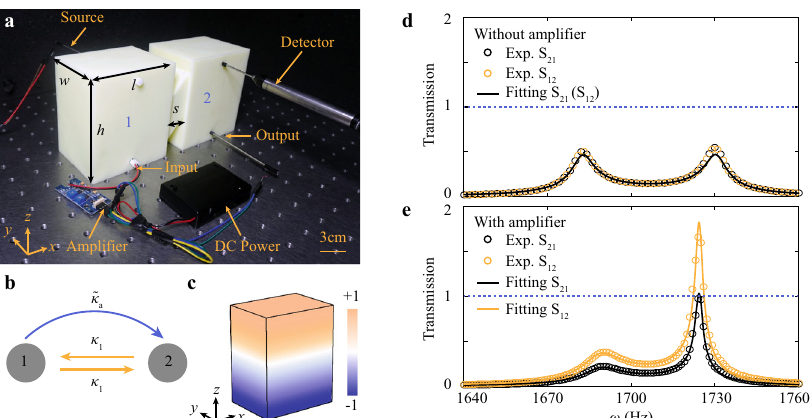
Fig. 2 Implementation of acoustic non-Hermitian non-reciprocal coupling. a Photograph of two acoustic resonators (labeled by “ 1 ” and “ 2 ” ) connected by two cross-linked narrow waveguides. The non-reciprocal coupling is implemented by an ampli fi er (equipped with a DC power supply), a microphone (input), and a speaker (output). A source and a detector are used to measure the transmission. b Simpli fi ed tight-binding model for the setup in ( a ). c Simulated acoustic pressure fi eld distribution of the dipole mode in a single resonator. d , e Experimentally measured (circles) and numerically fi tted (solid lines) transmission spectra for samples without and with the ampli fi er, respectively. The blue dashed line denotes the unity